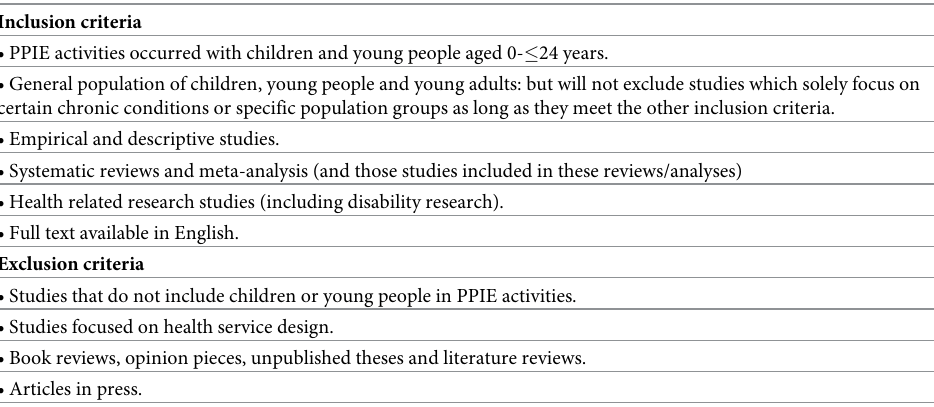
Table 1. Inclusion and exclusion